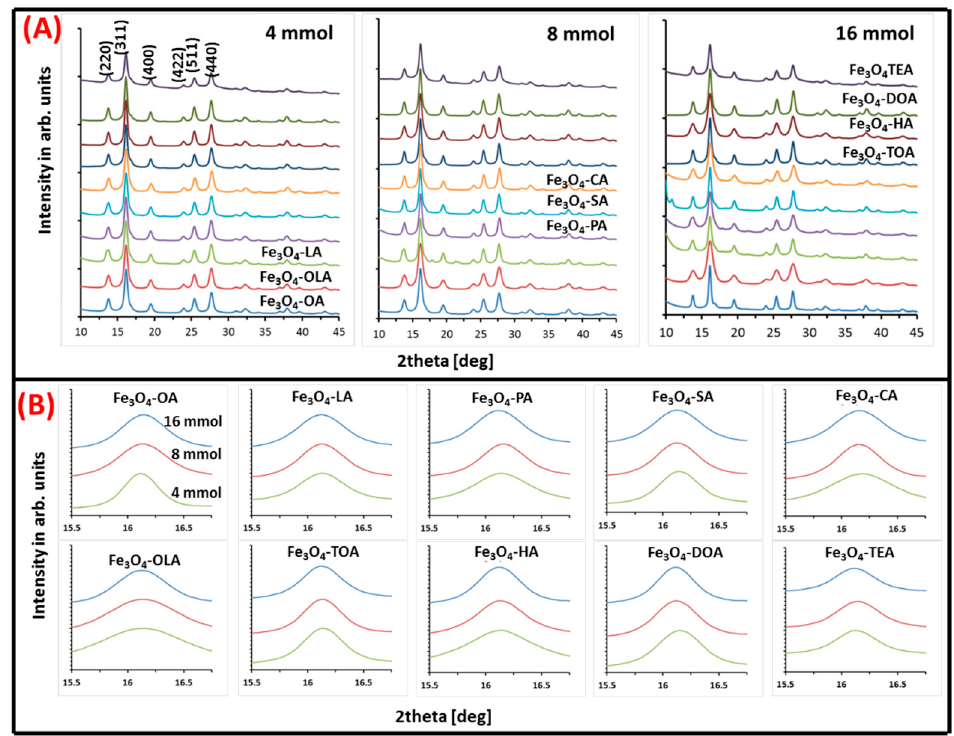
Figure 3. ( A ) Three series of X-ray diffraction patterns of obtained nanoparticles. Each series shows nanoparticles with specific concentrations of tested surfactants; ( B ) zoom on (311) peak in respect to surfactant and its concentration.